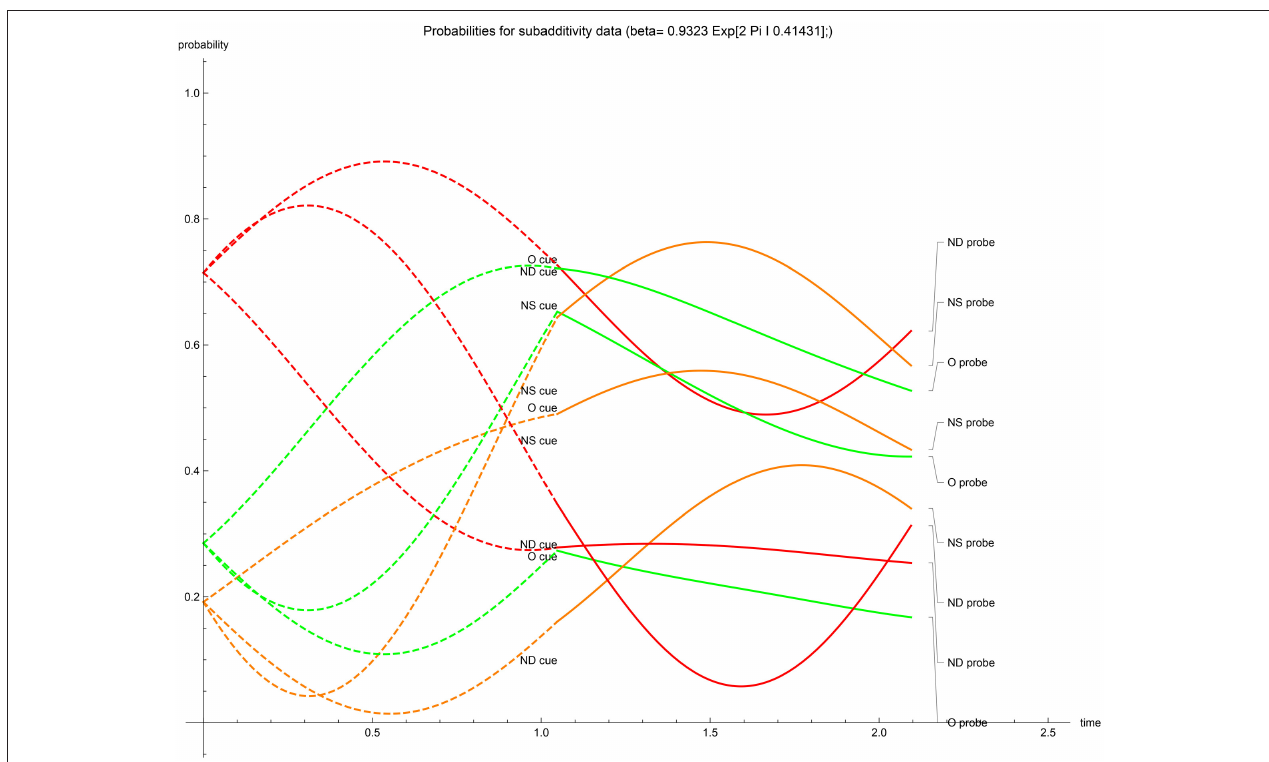
C case: temporal evolution of acceptance probabilities for the EOD-subadditivity paradigm [1]. Red indicates N probability component, orange FIGURE 5 | β ∈ indicates G probability component while green indicates V G probability component. Notice both verbatim and gist are present in the initial +